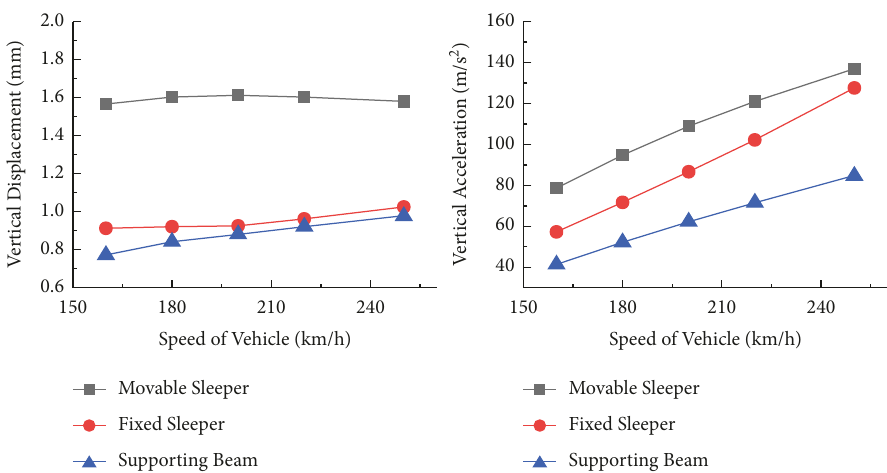
Figure 12: The maximum value of dynamic response of BEJs with different vehicle speed in Case